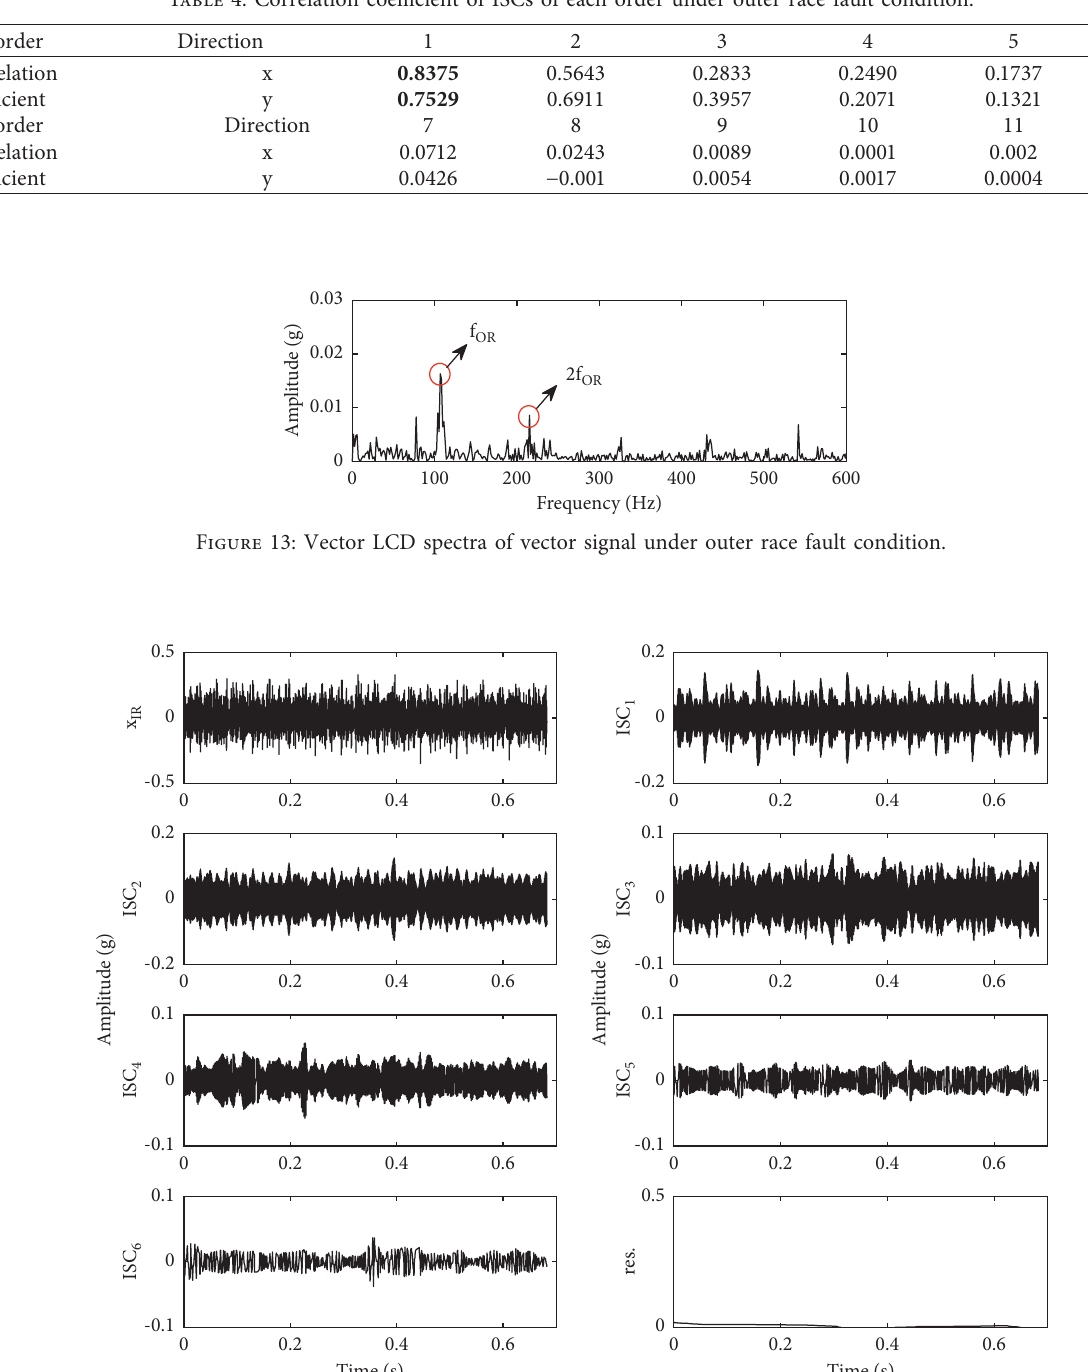
Figure 14: LCD decomposition results of x-channel under inner race fault condition.